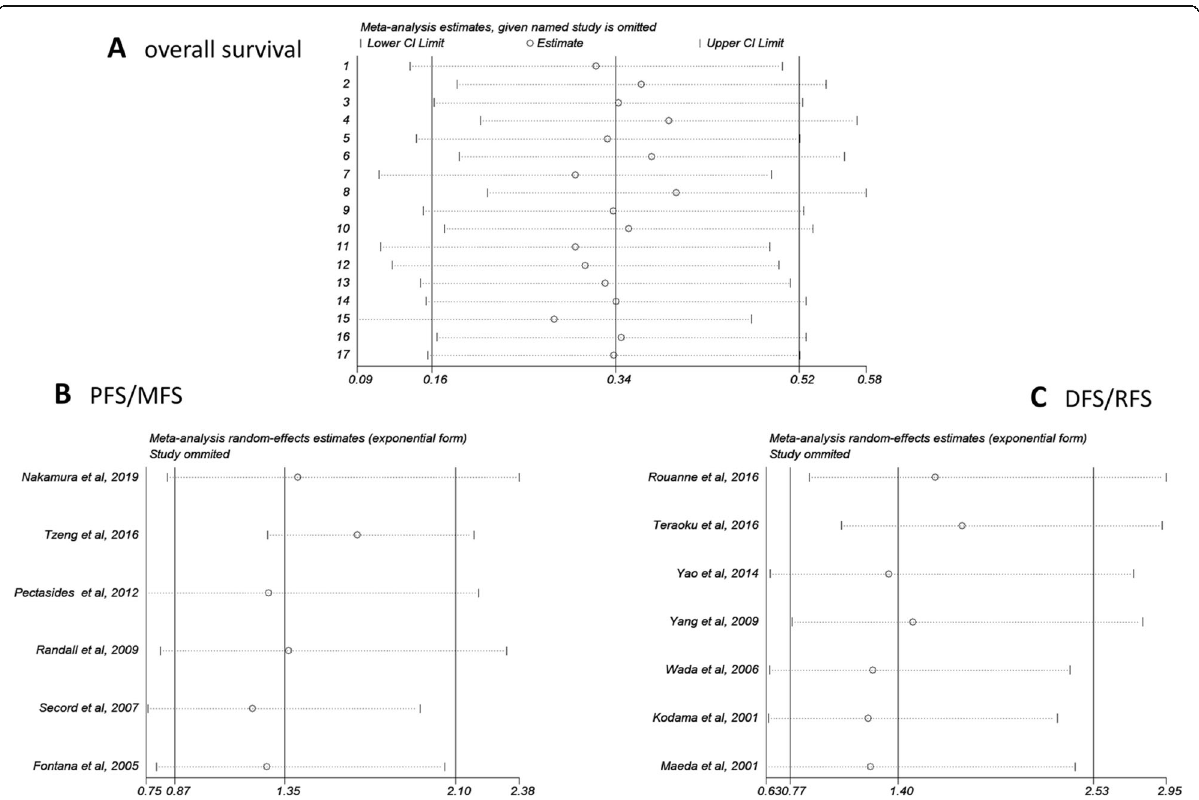
Fig. 6 Sensitivity analysis of each included study. (A) Sensitivity analysis of OS for individual studies. (B) Sensitivity analysis of PFS/MFS for individual studies. (C) Sensitivity analysis of DFS/RFS for individual studies. Abbreviations: OS, overall survival; PFS, progression-free survival; MFS, metastasis-free survival; RFS, recurrence-free survival; DFS, disease-free